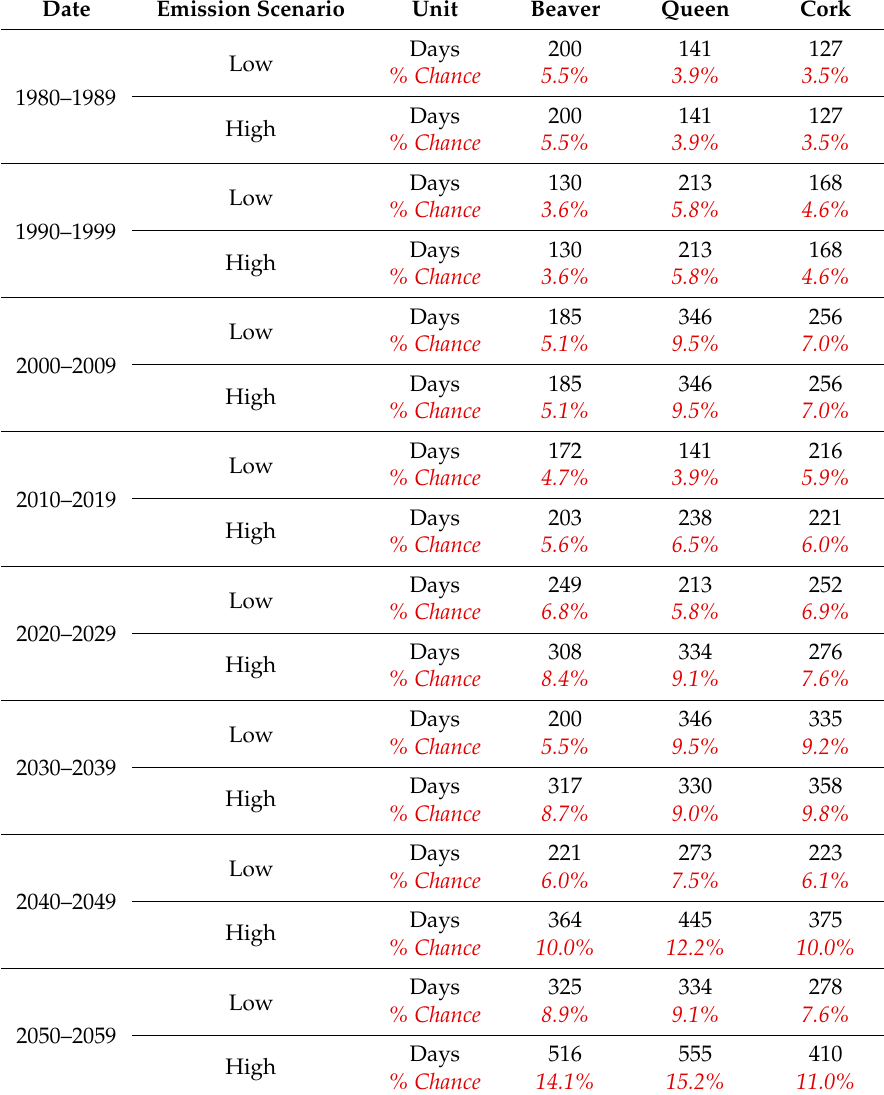
Table A1. Stressful event results for each watershed by decade. High and low CO 2 emission scenarios projected for short (2010–2039), medium (2040–2069) and long-term (2070–2099). Unchanged historical results included for